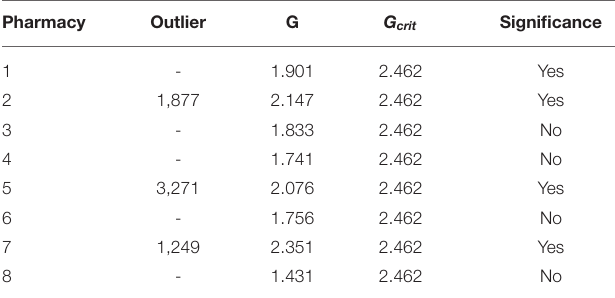
TABLE 13 | The results of Grubbs’ tests by pharmacies (product without shortage).